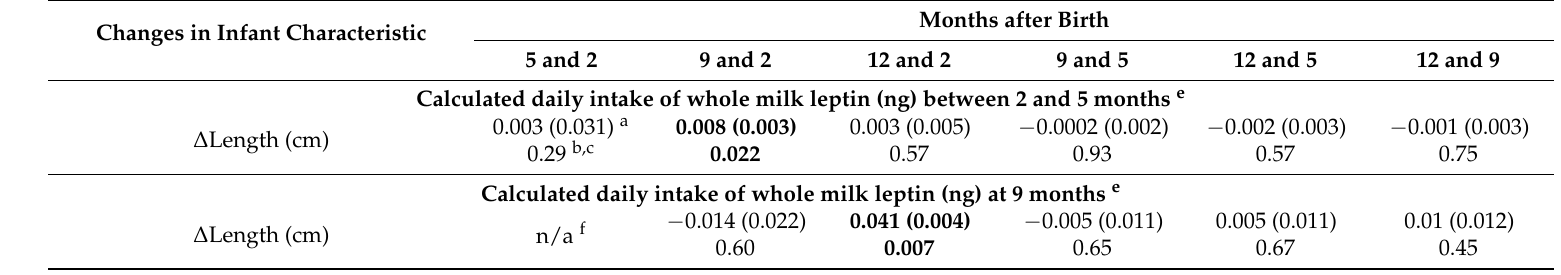
Table A5. Associations between calculated daily intakes of whole human milk leptin at given time points and infant body composition changes between the time